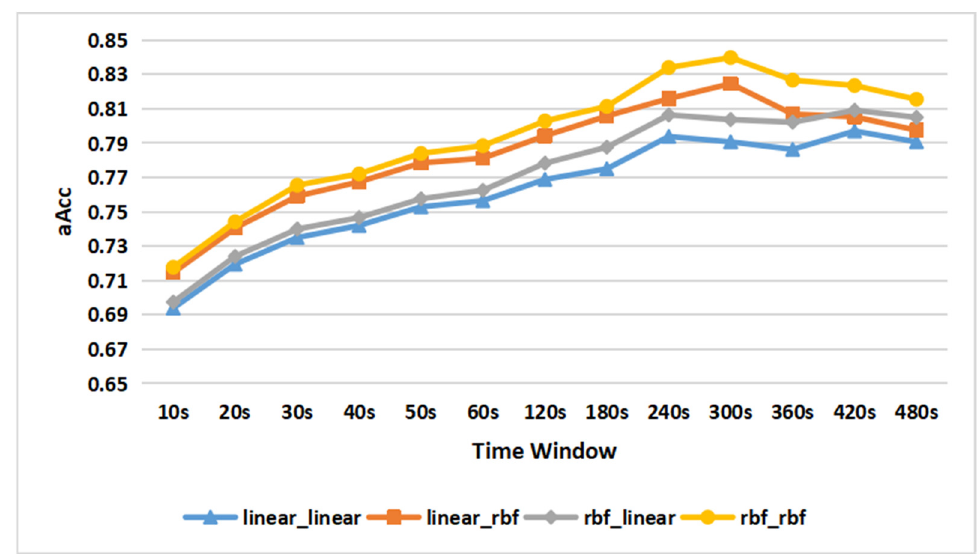
Figure 9. Comparison of the accuracy of SIURUA with different kernel functions.